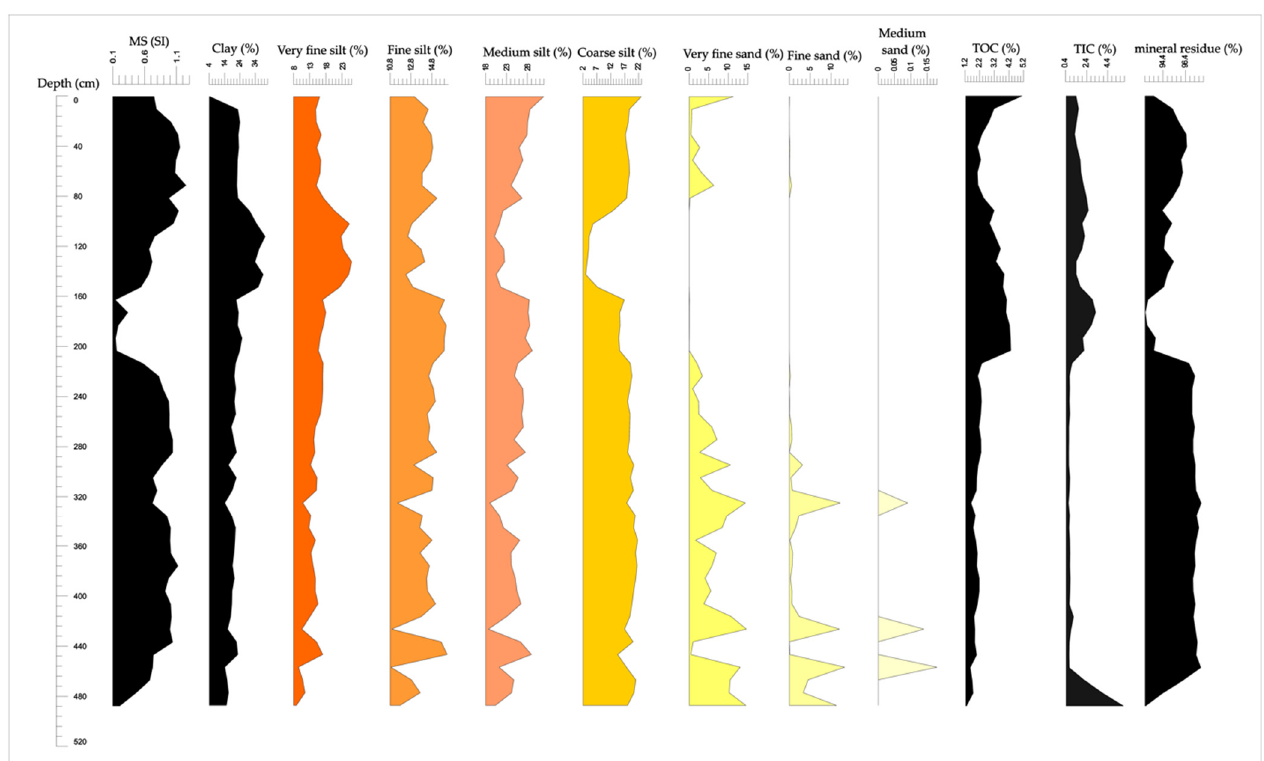
Figure 6. Results of the magnetic susceptibility measurements, grain size distribution and LOI measurements on the samples of 490 cm borehole of Császárné Mound.